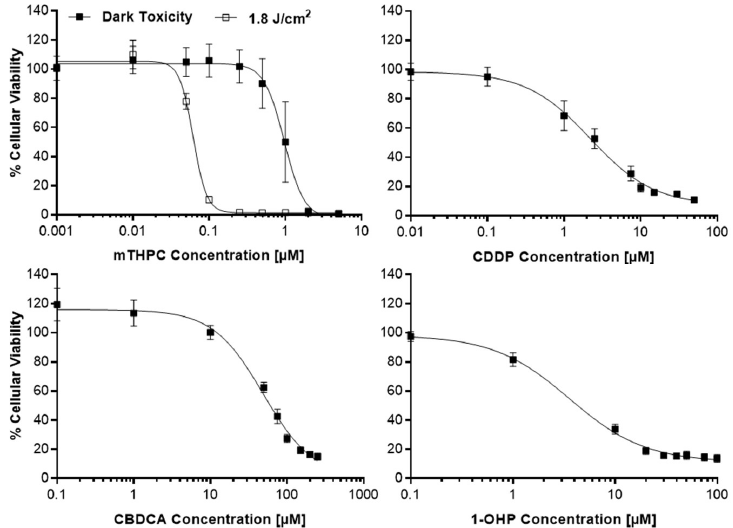
Figure A1. Dark ( ■ ) and light-induced (□) loss of cellular viability after mTHPC-mediated PDT or treatment with Pt(II) complexes cisplatin (CDDP), carboplatin (CDBCA) and oxaliplatin (1-OHP) as assessed by the MTT viability assay in SISO cells as a representative sample. Cells were treated with mTHPC for 24 h in concentrations ranging from 0.001–5.0 µM and kept in the dark (dark toxicity) or illuminated with light between λ = 640–660 nm and a light fluence of 1.8 J/cm 2 , applied at a fluence rate of 3.0 mW/cm 2 . MTT assay was carried out 24 h post illumination and the absorbance of the reduced formazan was measured at λ = 570 nm. The IC 50 values for the Pt(II) complexes were detected 48 h after treatment without illumination of the cells. Concentrations varied for CDDP (0.01–50.0 µM), CBDCA (0.1–250 µM; 0.001–5.0 mM for A-427) and 1-OHP (0.1–100 µM). The percentage of cell viability was calculated by dividing the absorbance for the treated group by the absorbance in the solvent dark control. IC 50 values were calculated using Prism 6. Results presented as means ± SD from at least three independent experiments.